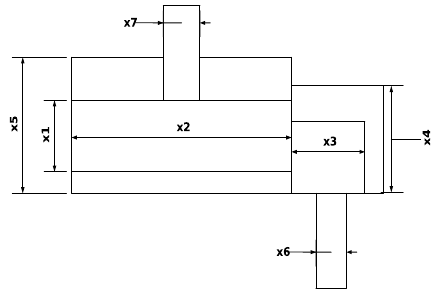
Figure 18. Schematic of speed reducer.